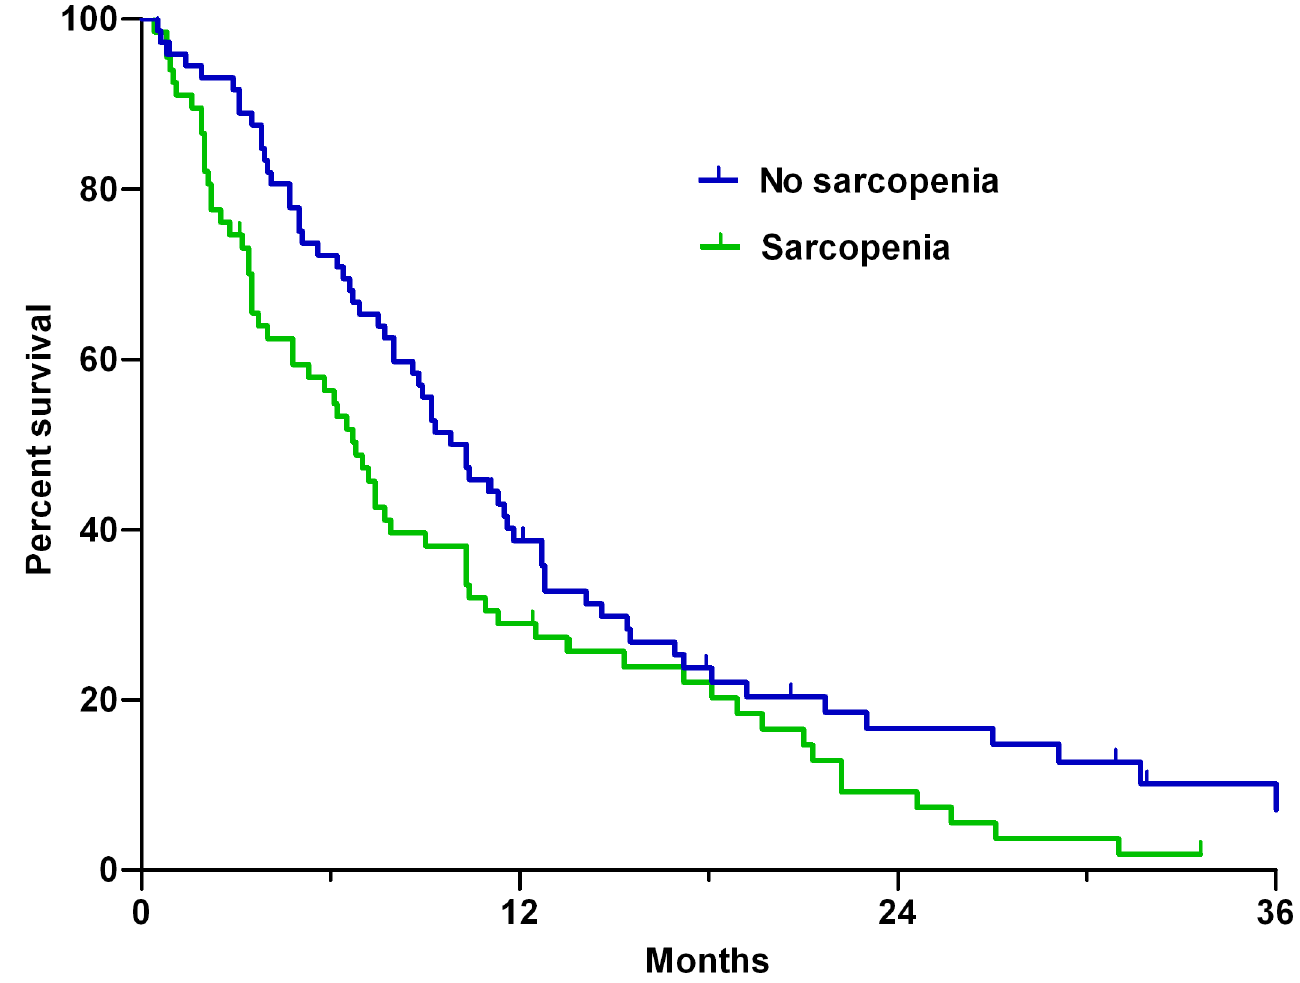
Fig 1. Kaplan–Meier estimates of overall survival in patients with and without sarcopenia.